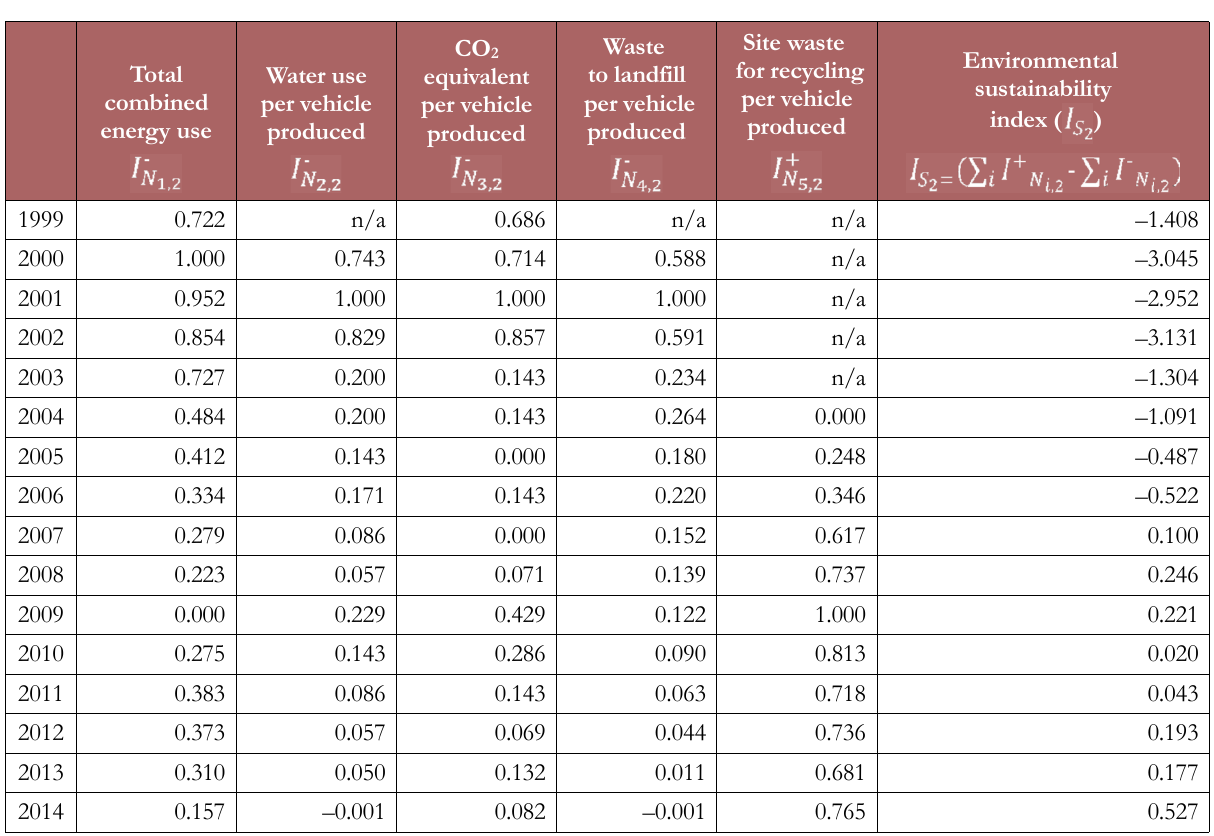
Table 6. Determination of the environmental sustainability index